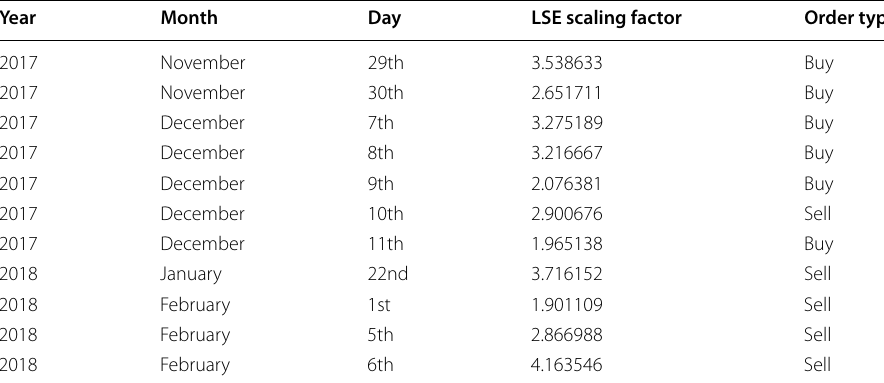
Table 2 List of large scale events associated with volume spikes, that are not explained by EoM